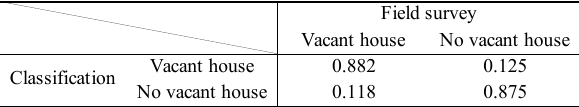
Table 3. Results of the accuracy assessment for the classification